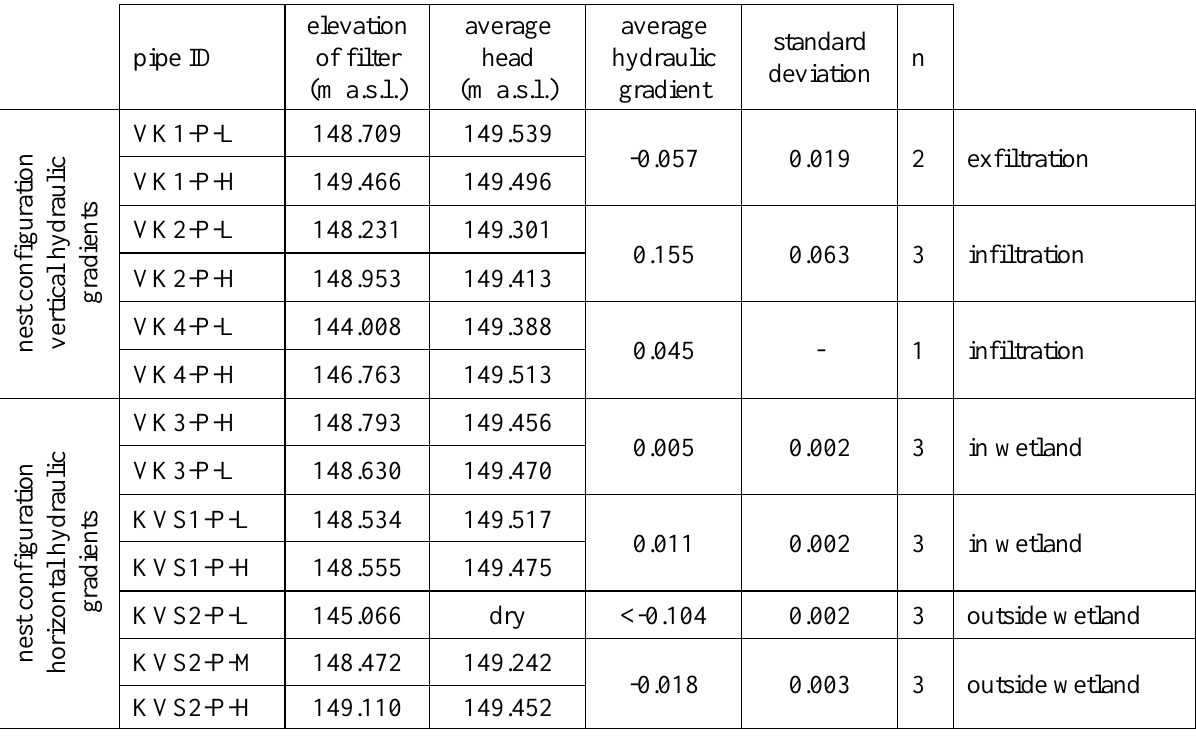
Table 1. Elevation of the filters of the piezometers (bottom of the screen) and average hydraulic heads over the three measuring periods between May and June